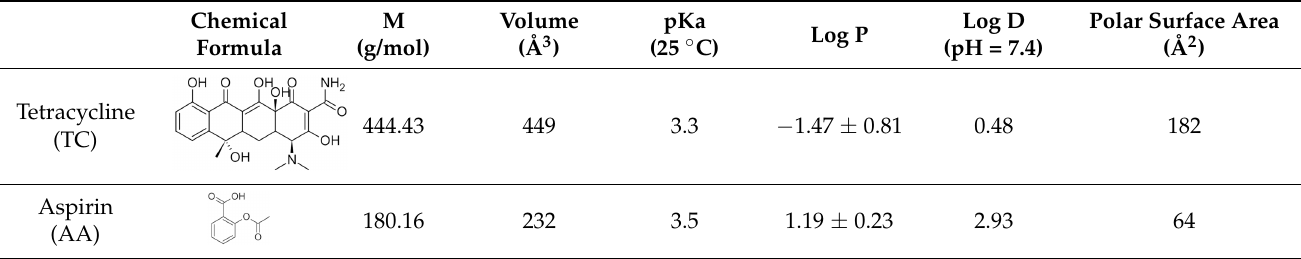
Table 6. Chemical formula and main characteristics of TC and